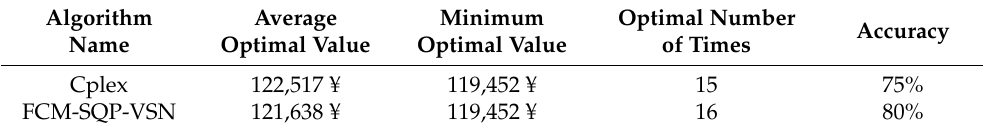
Table 9. Algorithm